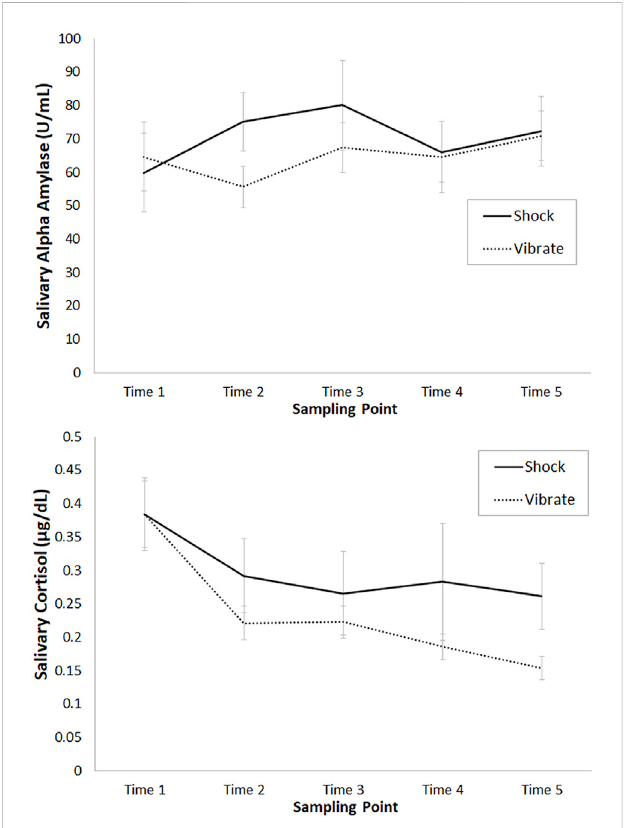
FIGURE 6 Mean untransformed salivary alpha amylase (upper panel, in U/mL) and cortisol (lower panel, in µg/dL) levels (and standard error) at each of the fi ve sampling times, for the shock versus vibrate conditions.